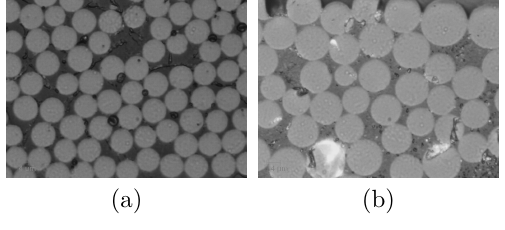
Figure 2. a) Maxwell chain unit, b) Relaxation